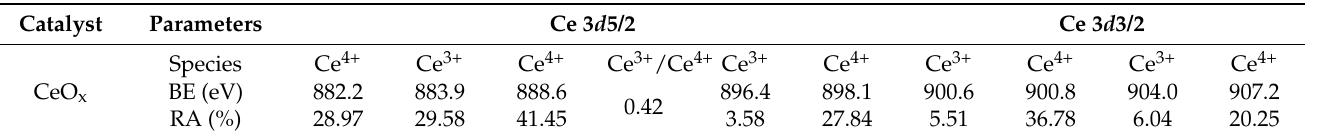
Table 2. Deconvoluted XPS spectrum of Ce 3 d distribution in the catalyst.